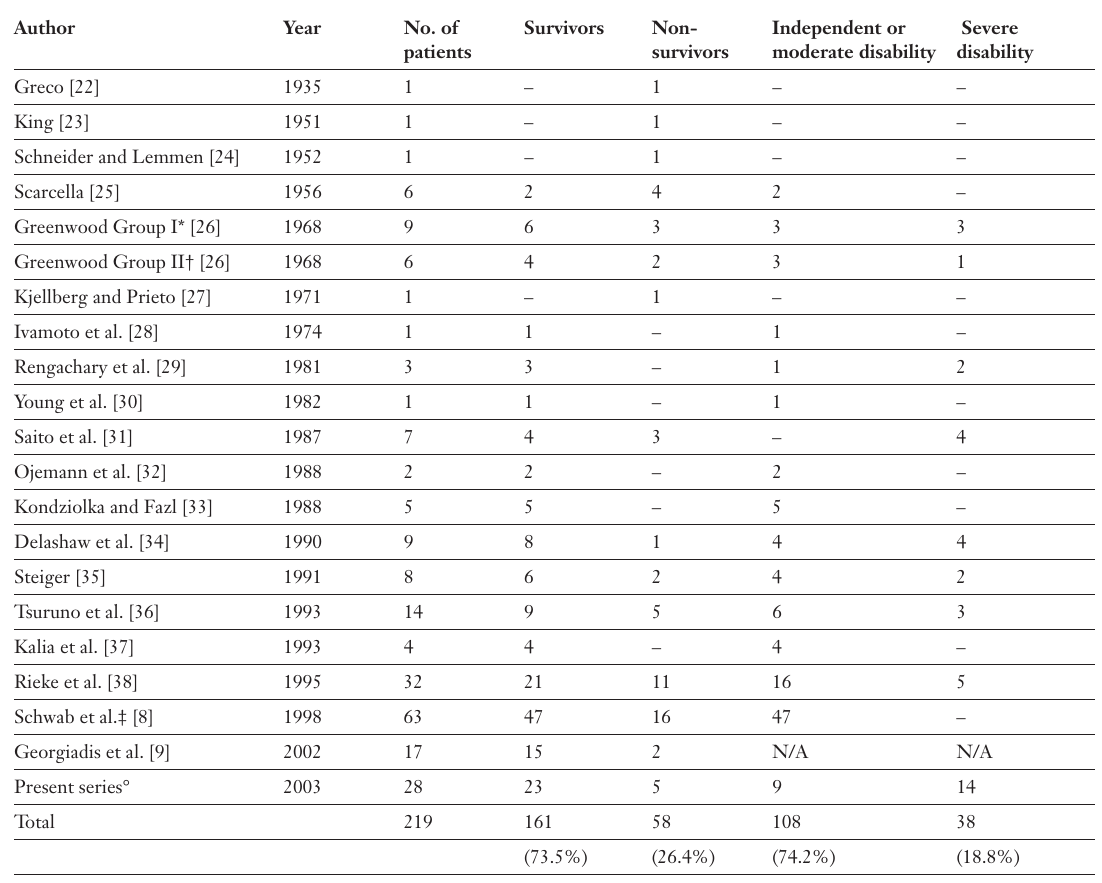
Clinical studies and case reports of decompressive craniectomy after hemispheric space- occupying cerebral infarction